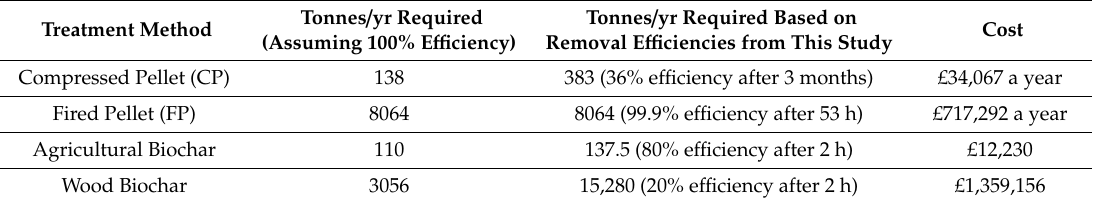
Table 4. Table showing the amount of pellets / biochar feedstock required in tonnes / yr to lower Zn levels to the fixed EQS at Chudleigh, based on EA metal concentrations in